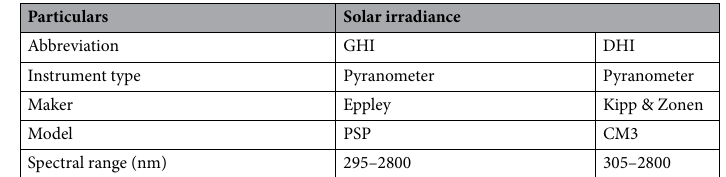
Table 3. Instruments used to measure solar irradiance in nests of Atta sexdens (Hymenoptera: Formicidae) in sunny and shaded environments. Fonte: Campbell Scientific 42,43 .